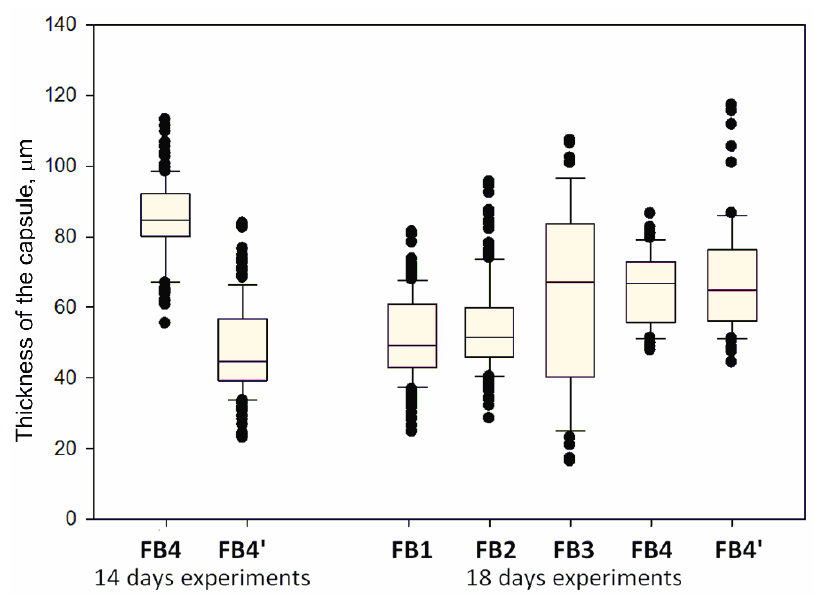
Figure 10. The thickness of the connective tissue capsule (μm) formed after subcutaneous implantation of the films FB1 – FB4 and FB4 ′ .